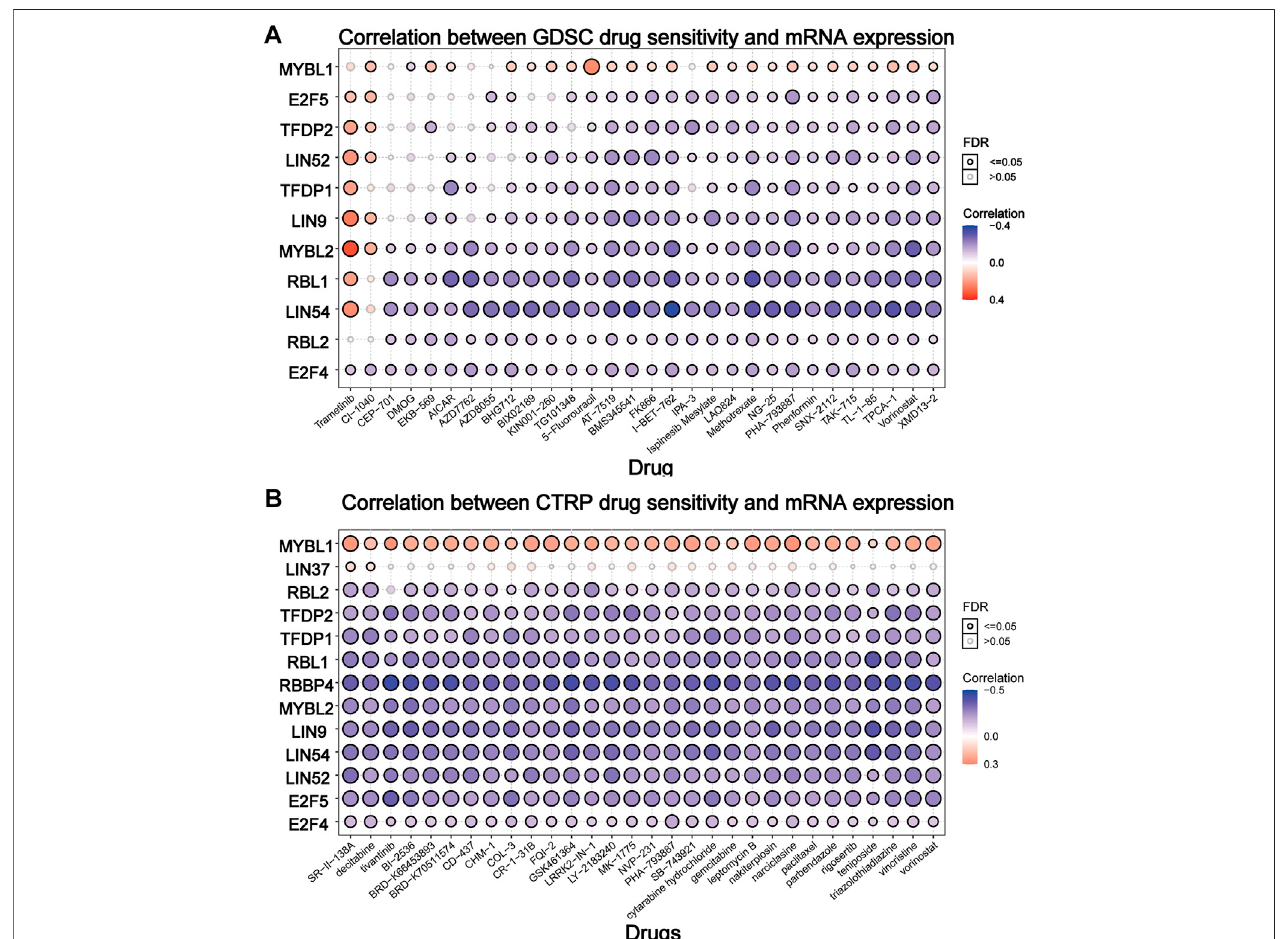
FIGURE6| DrugsensitivityanalysisoftheDREAMcomplex.Thegenesetdrugresistance analysisfromGenomics ofDrugSensitivity inCancer(GDSC)IC50 drug data and The Cancer Therapeutics Response Portal (CTRP). Spearman ’ s correlation represents how the gene expression correlates with a drug. The horizontal axis representsdifferentdrugs.Bluerepresentsnegativecorrelationsandredrepresentspositivecorrelations.BlackcirclesindicateFDR < 0.05andgraycirclesindicateFDR > 0.05.